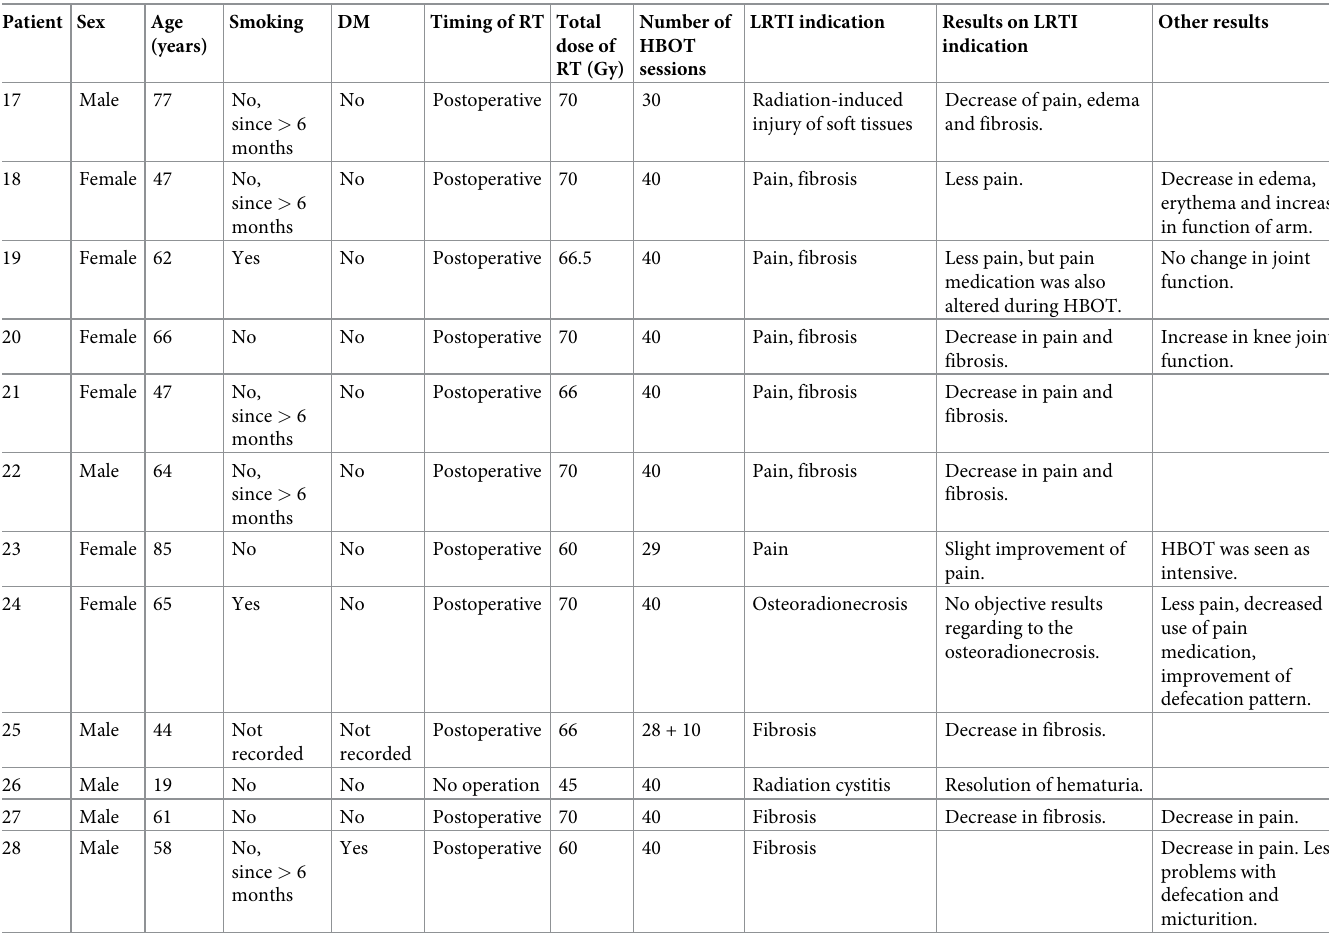
Table 3. Effects of HBOT on